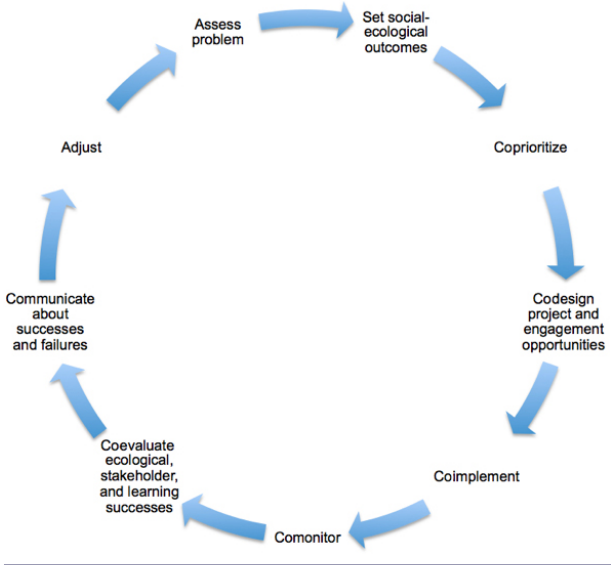
Fig. 1 . Framework for incorporating iterative public engagement into the adaptive comanagement of natural resources (adapted from Nyberg 1999). This ideal model can be used as a guiding framework, even if portions of the process may be difficult to adopt because of logistical, chronological, and financial